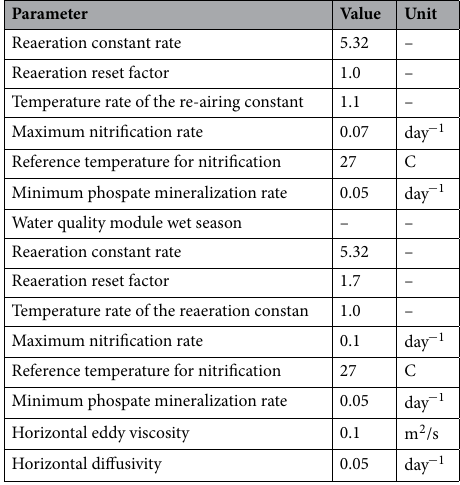
Table 2. Coefficient and constants used for the water quality model.